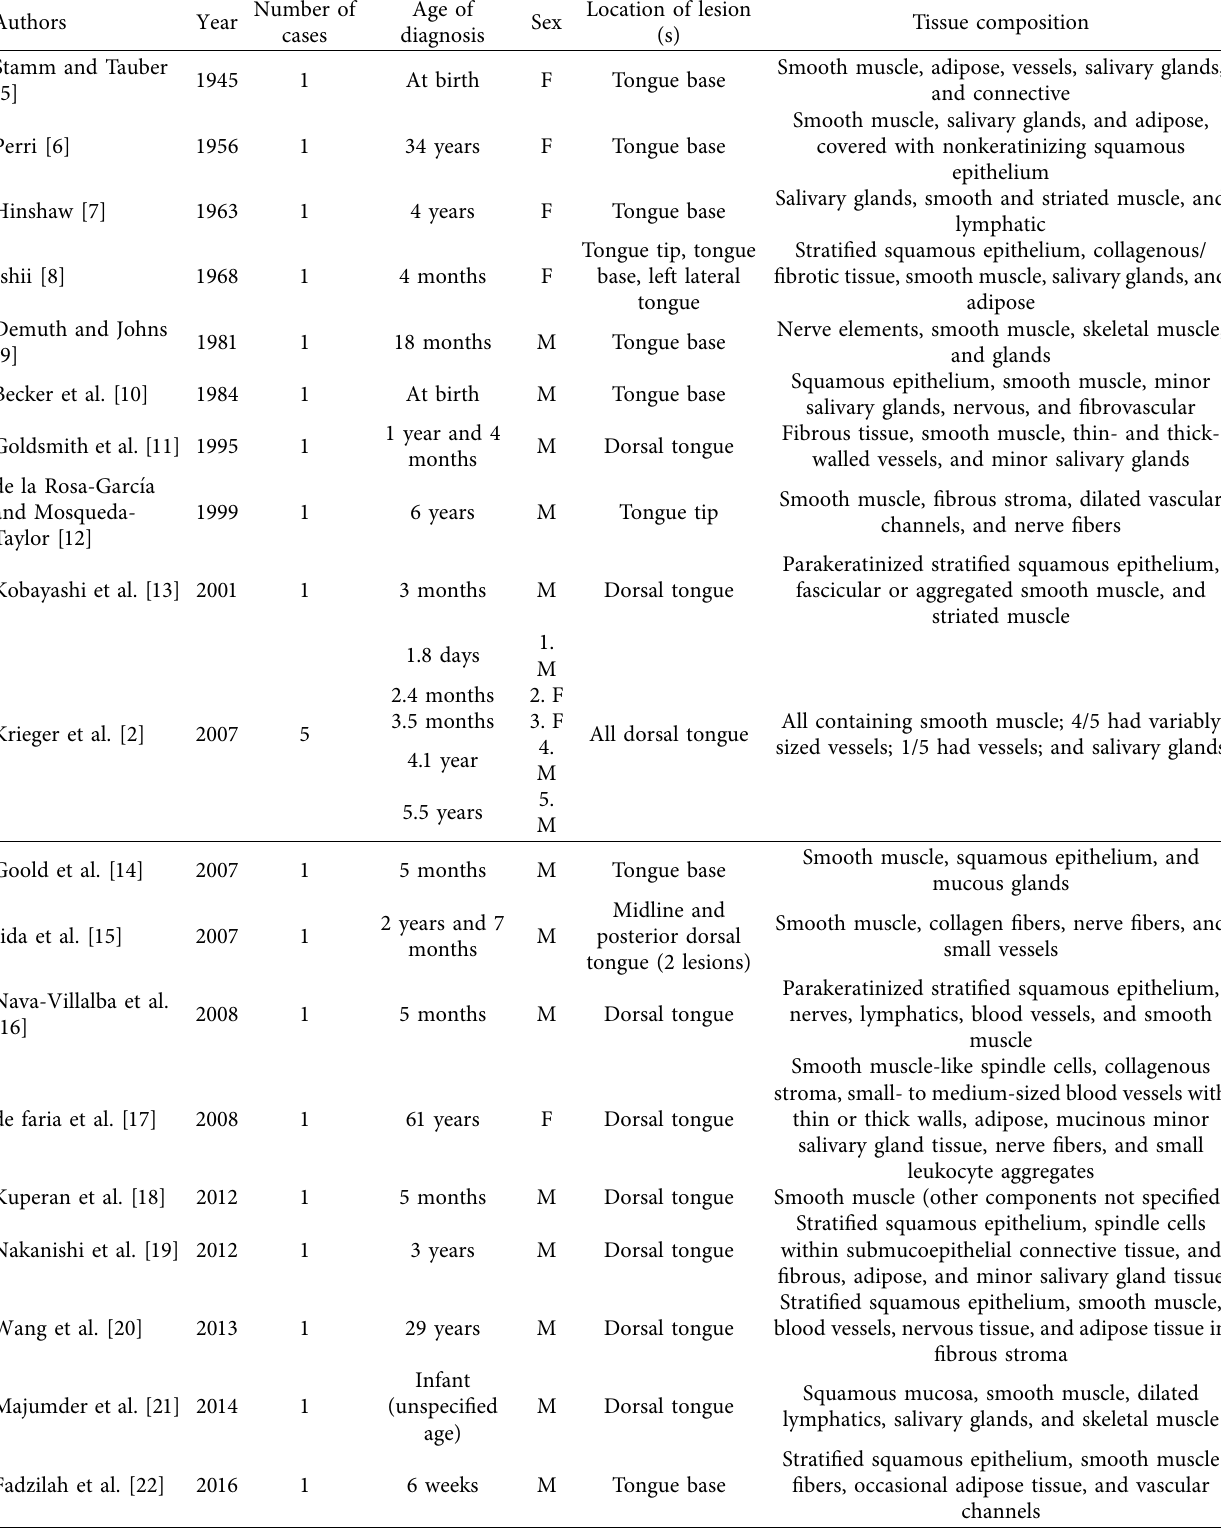
Table 1: Summary of lingual leiomyomatous hamartoma cases reported in the English literature to